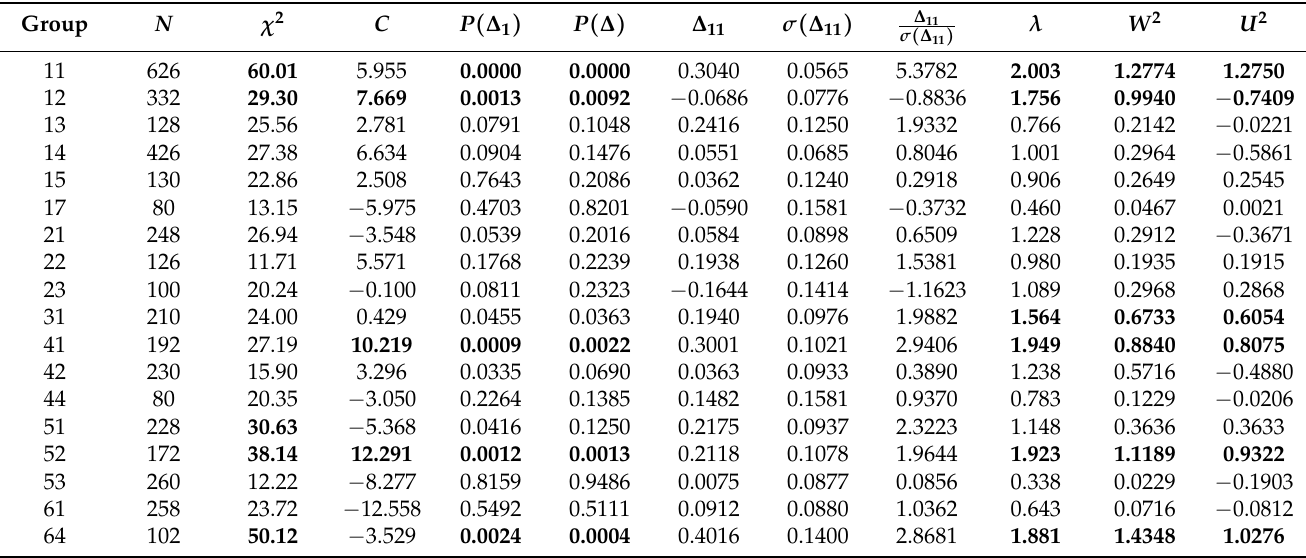
Table 2. Test for isotropy of the orientations of the galaxy plane. The distribution of the angle η of galaxies; inclination was taken directly from the NBG